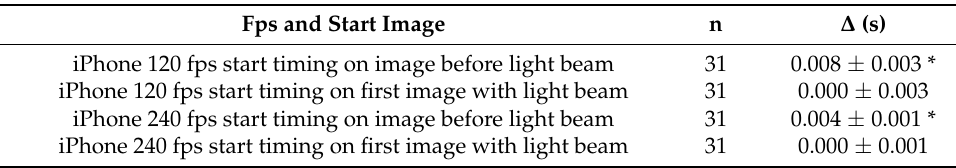
Table 1. Main difference ( ± SD) between iPhones and the